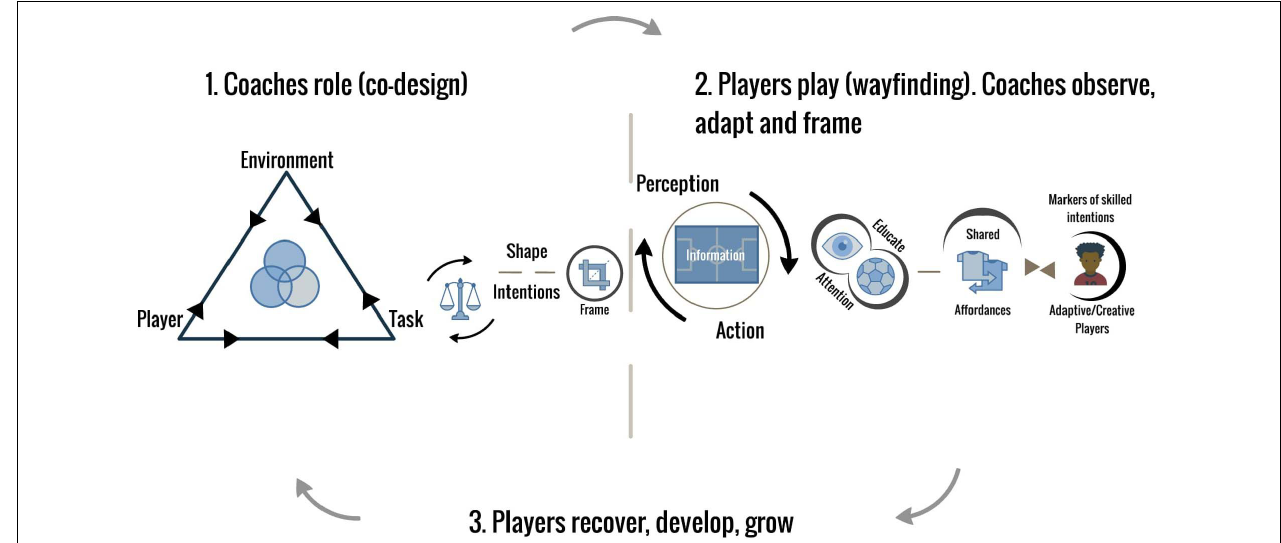
FIGURE 2 | Player learning IN development framework, part of AIK football club’s player development cycle.